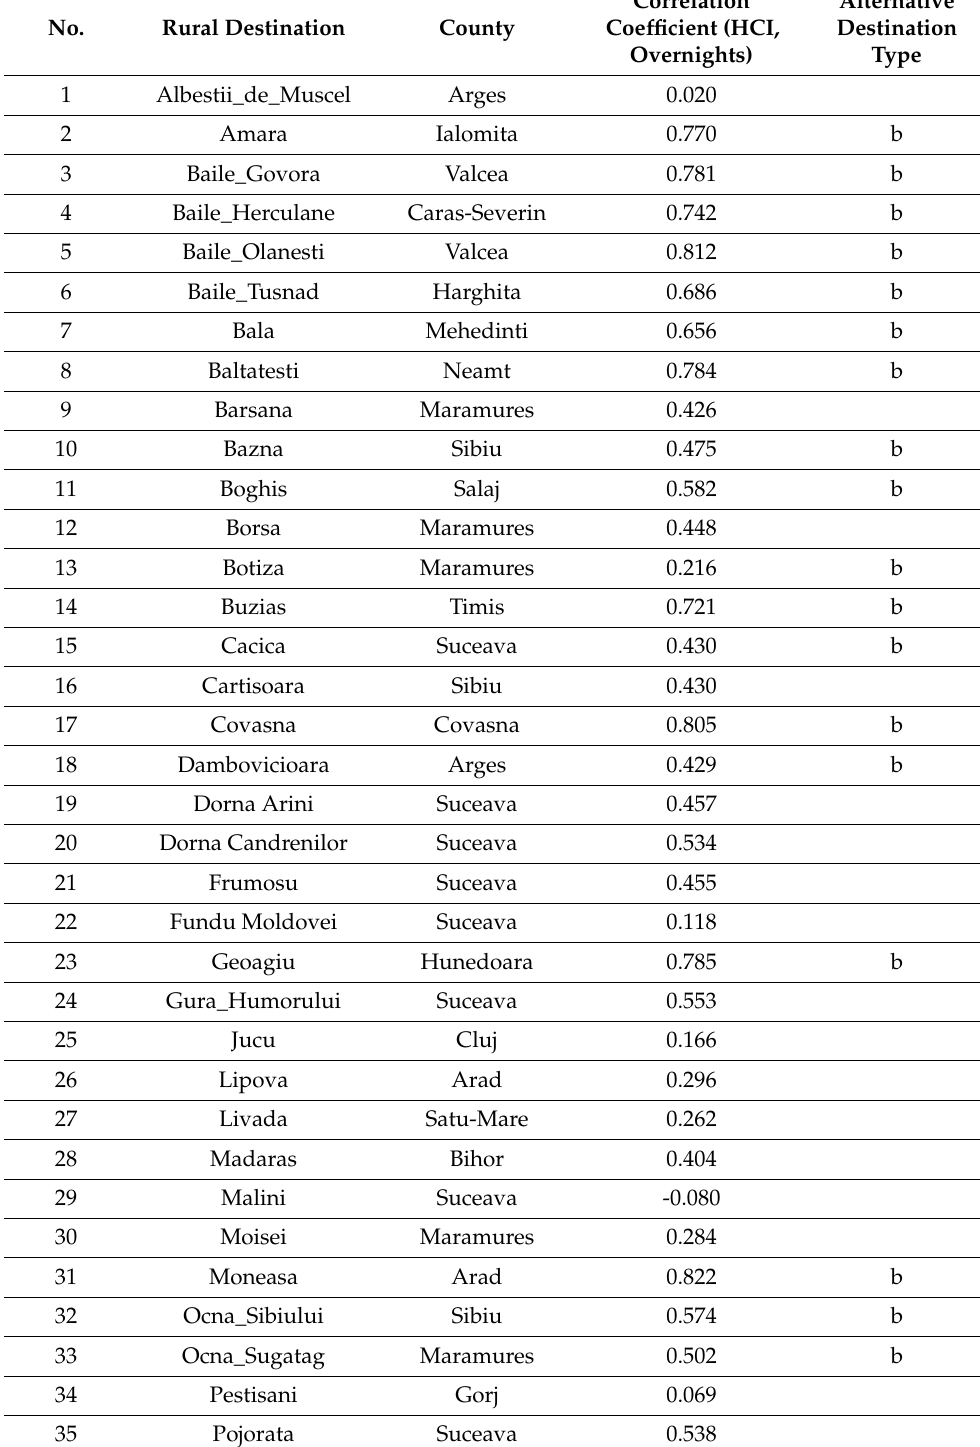
Table 3. The correlation coefficient between the monthly mean HCI and monthly mean number of overnight tourists for 2010–2018, for rural destinations. As an alternative destination type, balneary tourism is denoted by the letter ‘b’ in the last